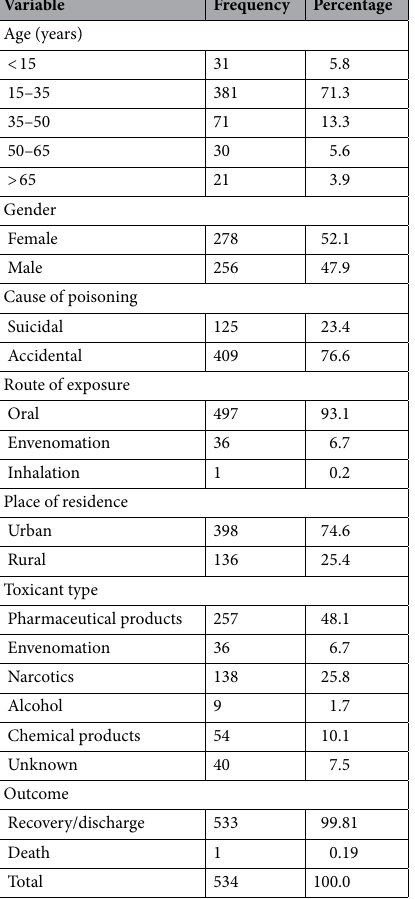
Table 1. Description of poisoned patients of Imam Reza Hospital, Birjand, September 2017 to August 2018 (n = 534).